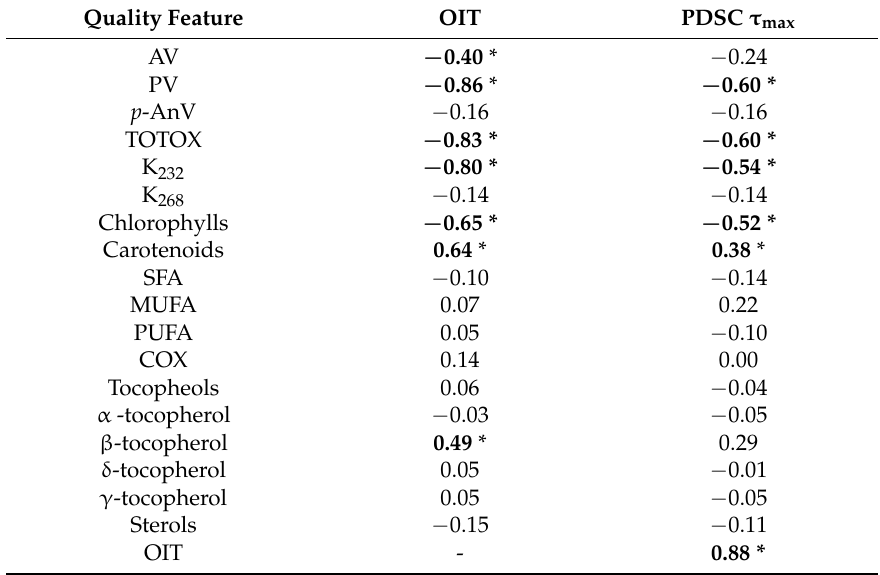
Table 4. Correlation coefficient for oxidative stability and different quality features of